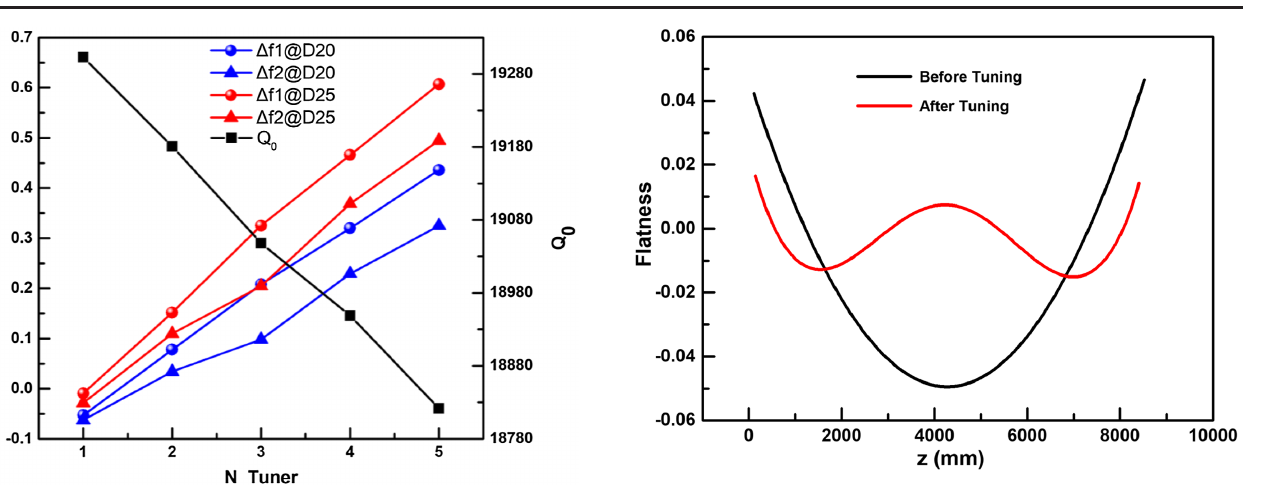
FIG. 12. Frequency tuning capability of tuners.